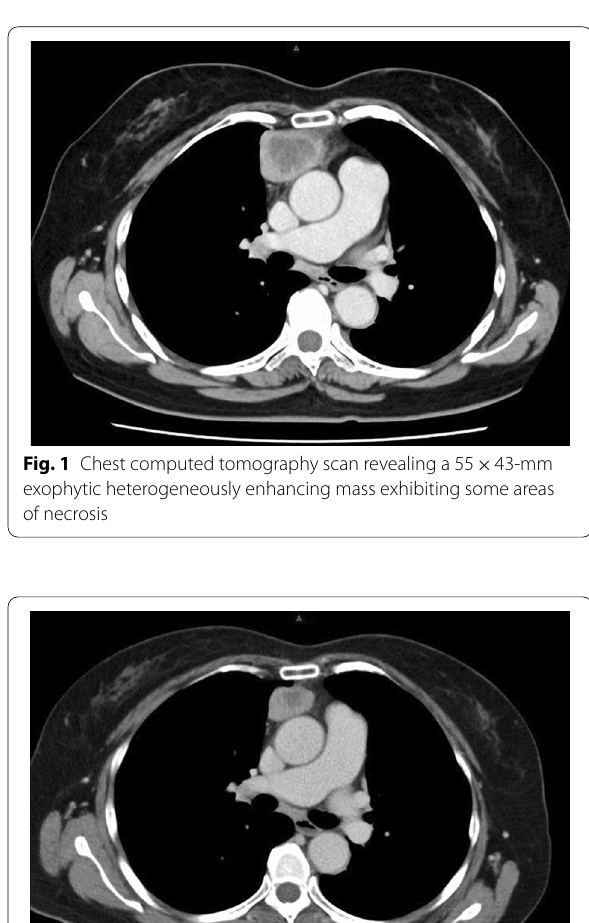
Fig. 2 Chest computed tomography scan just before the operation revealing that the mass had regressed in size in the past